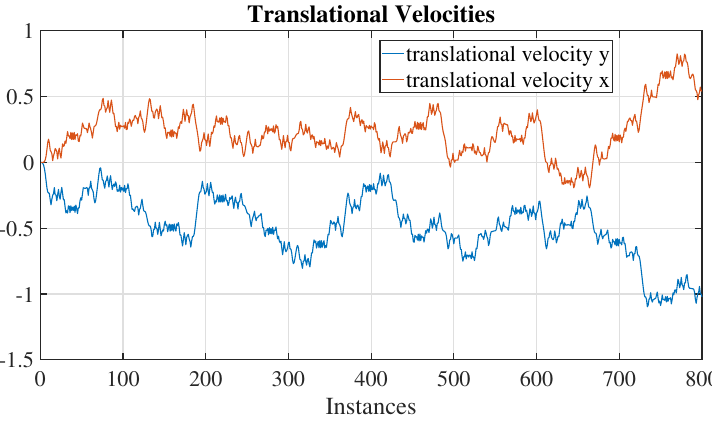
Figure 7. Translational velocities x , y .